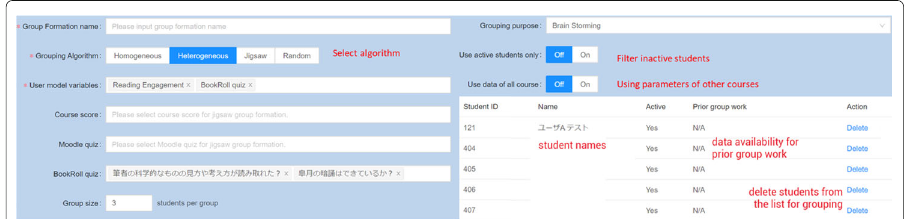
Fig. 7 Parameter setting options in Group Formation Module in